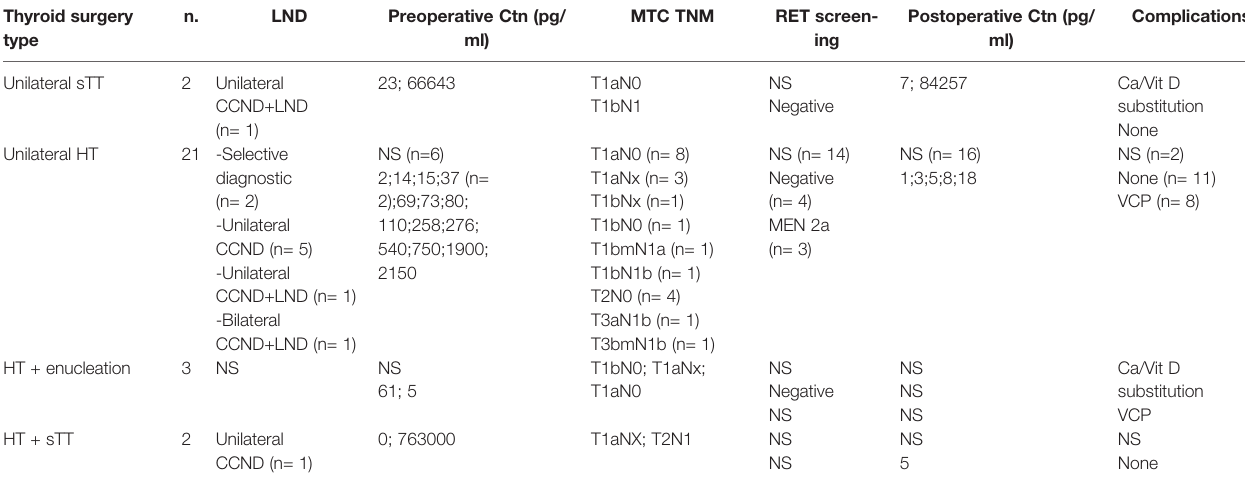
TABLE 2 | Clinical, pathological and biochemical features of MTCs treated with different types of surgery in the interim analysis of the DGAV (German Society for General and Visceral Surgery) CASMED study - StudDoQ Thyroid/Parathyroid Registry. Thyroid surgery type